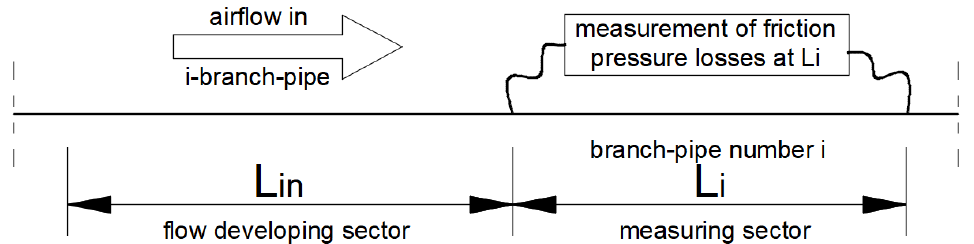
Figure A1. Noninvasive method of measuring the airflow in each (i) pipe of a multipipe EAHE, prepared on the basis of author’s previous work [43] (Figure 2).